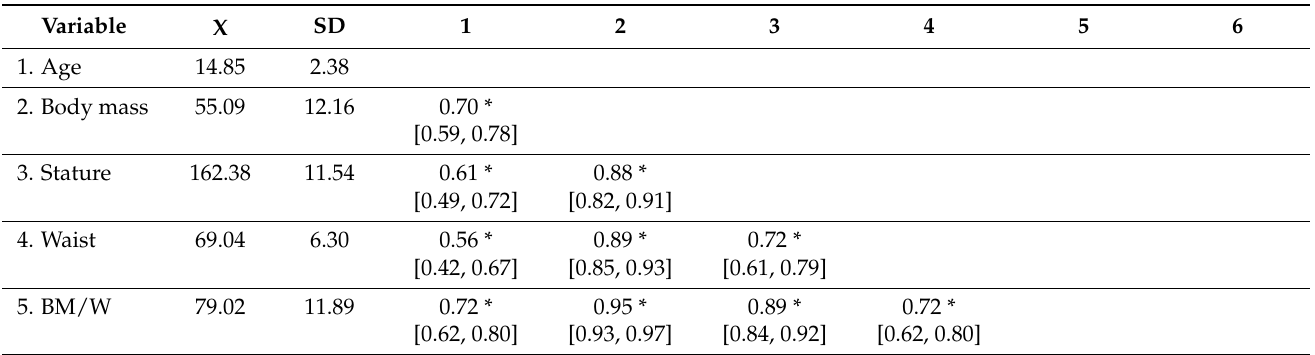
Table 2. Means, standard deviations and correlations with confidence